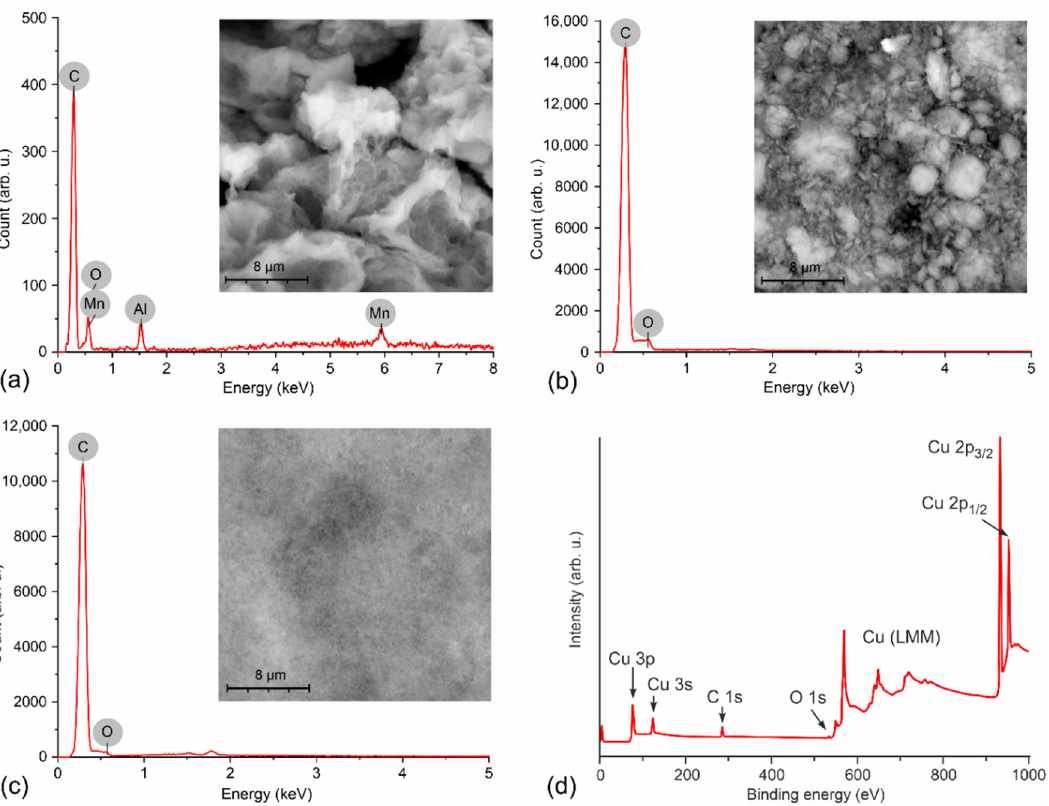
Figure 2. SEM images of prepared graphene layers of the tested sensors and results of chemical element content analysis by EDS for ( a ) rGO, ( b ) Gnp, and ( c ) Gpl and ( d ) XPS spectrum of prepared graphene on copper foil (Gcvd). Table 1. Atomic percentages of various elements in graphene-based materials.